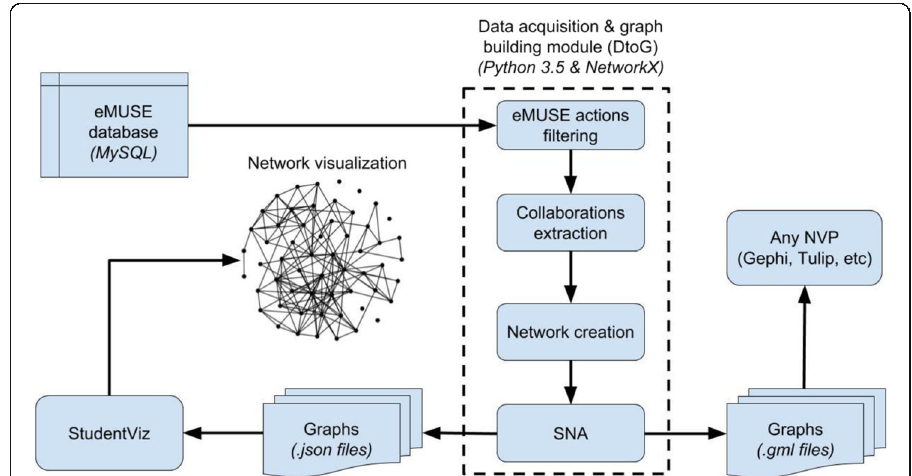
Fig. 1 StudentViz - network visualization data